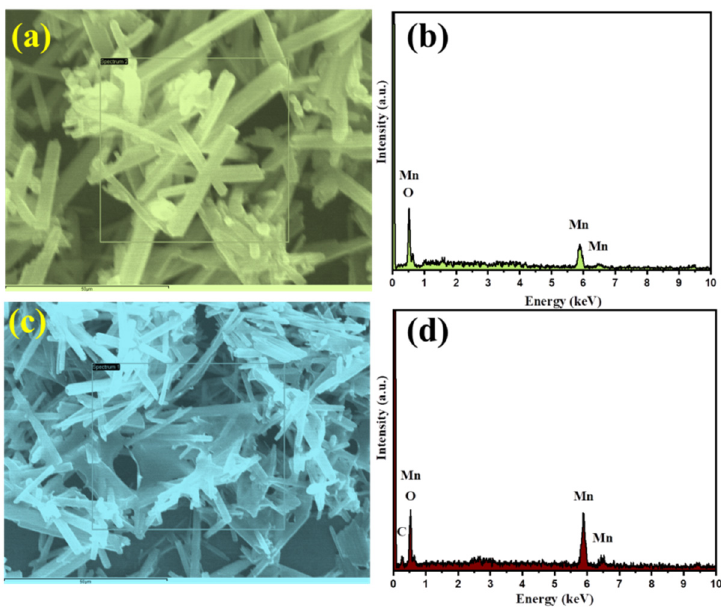
Figure 3. EDX analysis of MnO 2 ( a , b ) and MnO 2 /rGO ( c , d ).